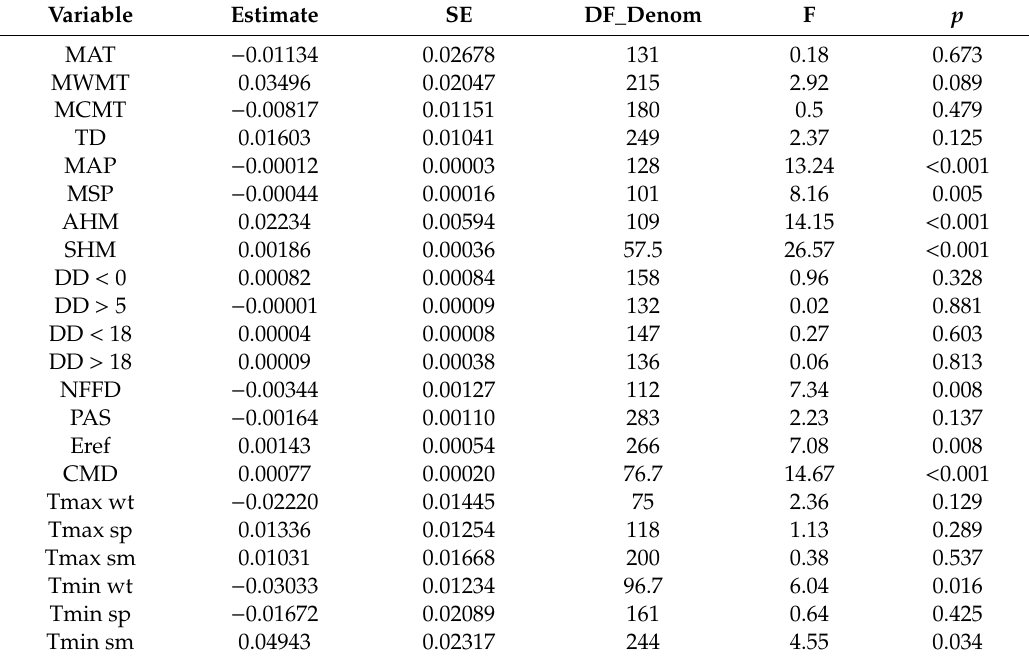
Table 5. F-test results relating % dry length to annual and seasonal climate variables (Table 3) in simple linear models. Intercepts are not shown. All tests were based on 362 observations with one degree of freedom in the numerator. The response variable (% dry length) was transformed using a logit transformation prior to analysis.